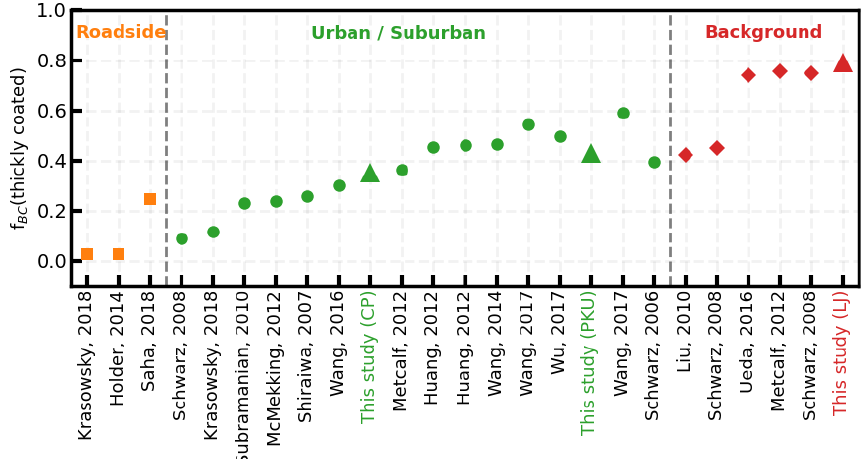
Figure 3. Measured number fraction of the thickly coated BC under different atmospheric environments based on literature. Our measured values are shown as